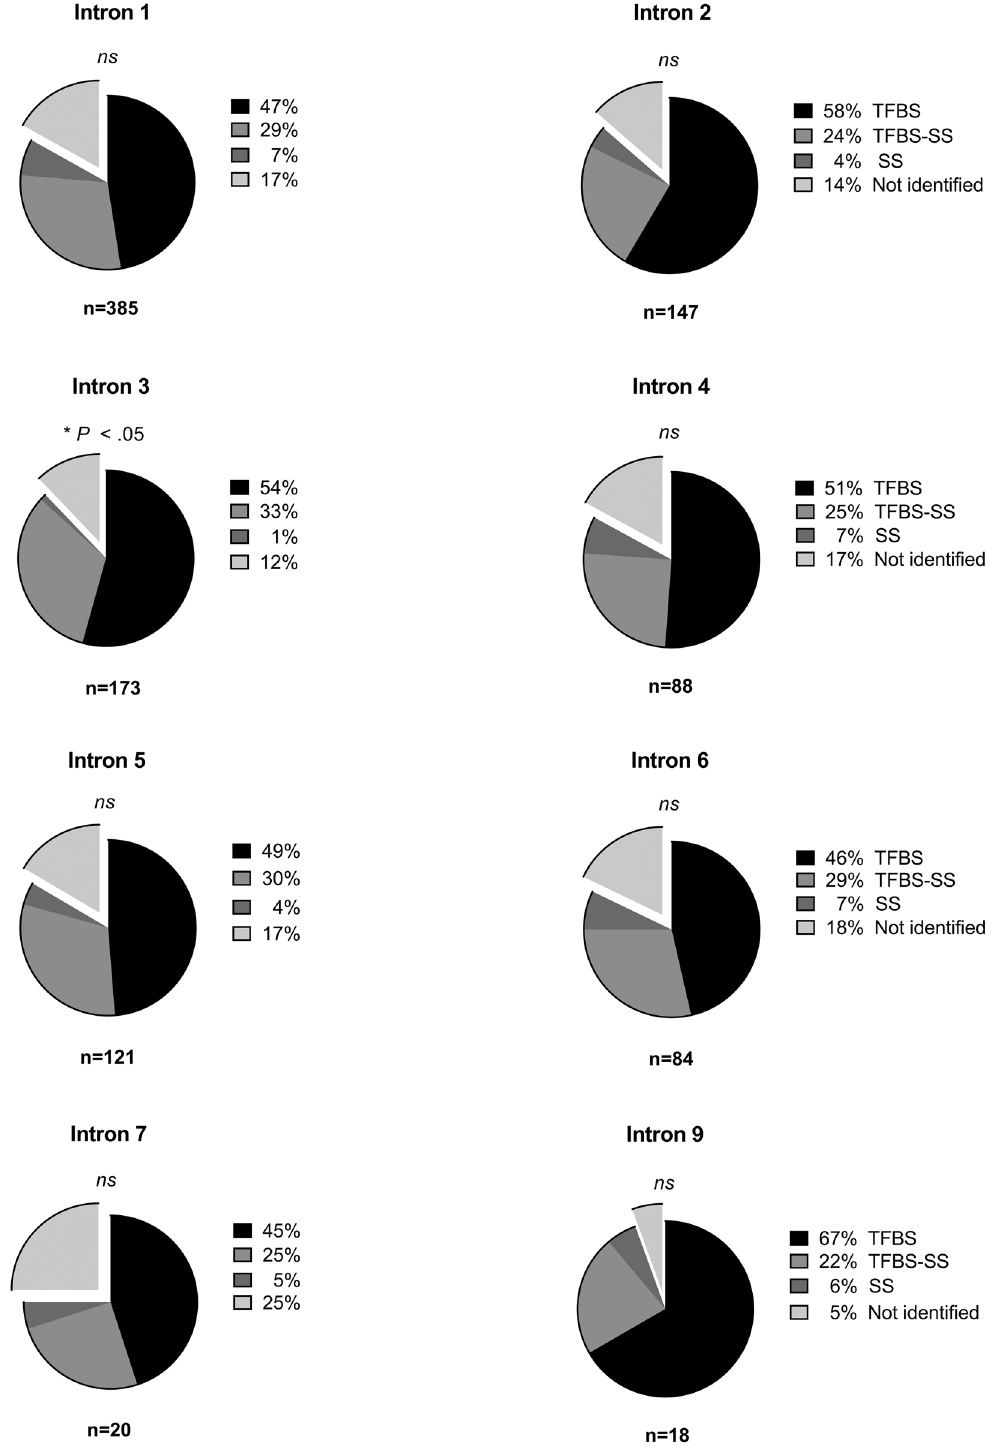
Figure 2: Frequency distribution of conserved pattern groups in intron 1 – 9 for the 25 analyzed genes. Conserved patterns were classi fi ed into four di ff erent groups: TFBS, TFBS - SS, SS, and not identi fi ed. The TFBS - SS group contained patterns that were identi fi ed as both TFBS and SS. Intron 8 is excluded due to the low number of conserved patterns shown in this intron ( n = 8 ) . Frequency distribution of the four groups ( TFBS, TFBS - SS, SS, and Not identi fi ed ) among introns was analyzed with Chi - square test ( * P < 0.05, ** P < 0.01, *** P < 0.001, **** P < 0.0001 )